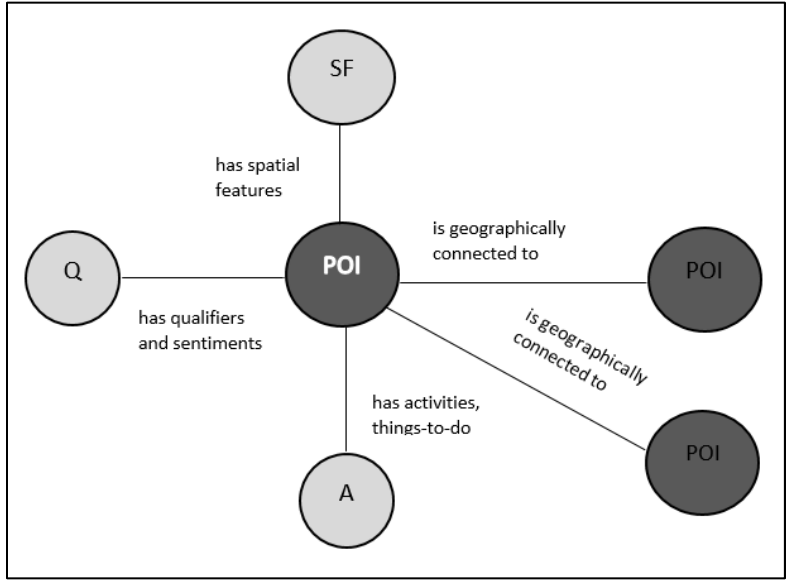
Figure 2. Proposed semantic model of a